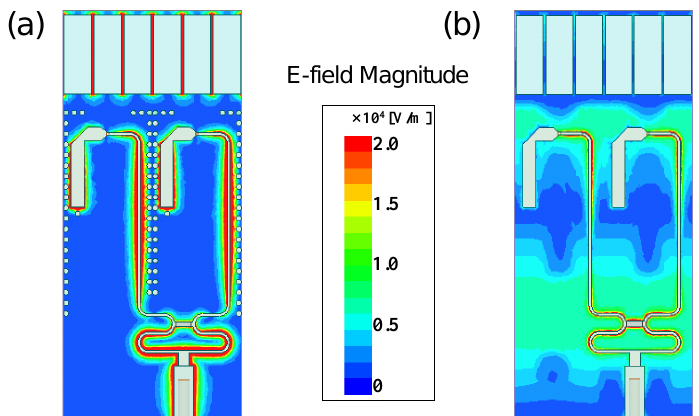
Figure 10. Simulated E-Field magnitude distribution of the proposed array at 11.7 GHz when scanning to broadside. ( a ) With plated-through vias (non-resonance); ( b ) Without plated-through vias